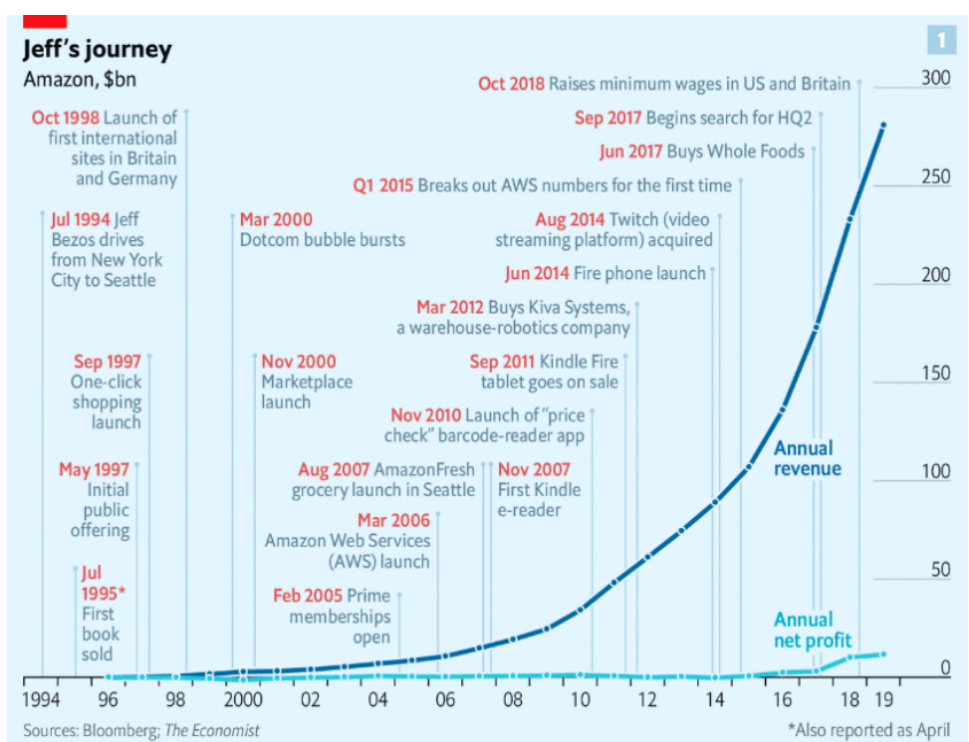
Figure 1. Timeline of Amazon’s corporate development 1994/1995–2019. Source: “Can Amazon keep growing like a youth- ful startup?” (2020, p.